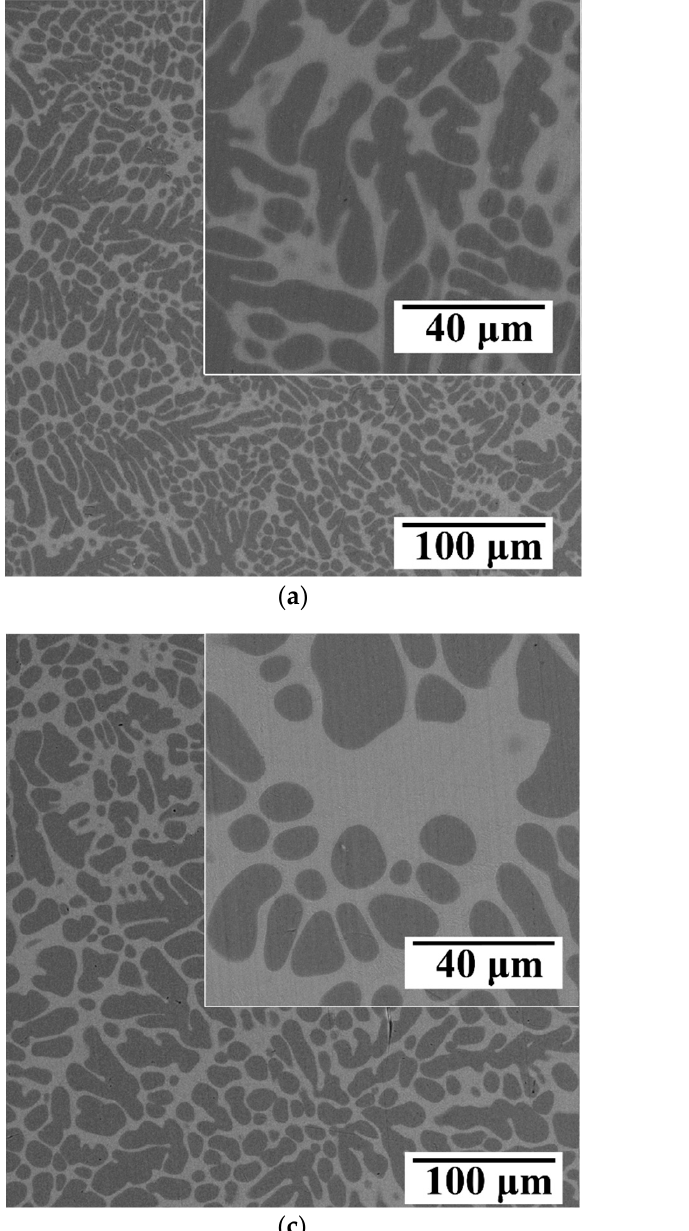
Figure 12. Mechanical properties of the Al3Ca0.5Cu and Al3Ca1Cu sheet alloys. 4. Summary (1) The liquidus projection of the Al-Ca-Cu system in the aluminum corner was sug- gested based on experiential studies of the microstructure and phase composition of model alloys. The suggested structure of the diagram has two quasi-binary sections: (Al)-Al 27 Ca 3 Cu 7 and (Al)-Al 8 CaCu 4, and three invariant ternary eutectic transfor- mations: L → (Al) + (Al,Cu) 4 Ca + Al 27 Ca 3 Cu 7 (at 5.6 wt.% Ca, 4.5 wt.% Cu, 595 °C), L → (Al) + Al 27 Ca 3 Cu 7 +Al 8 CaCu 4 (at 2.2 wt.% Ca, 13.5 wt.% Cu, 594 °C) and L → (Al) + Al 8 CaCu 4 + Al 2 Cu (at 0.5 wt.% Ca, 34 wt.% Cu, 544 °C). The eutectic point in the quasi-